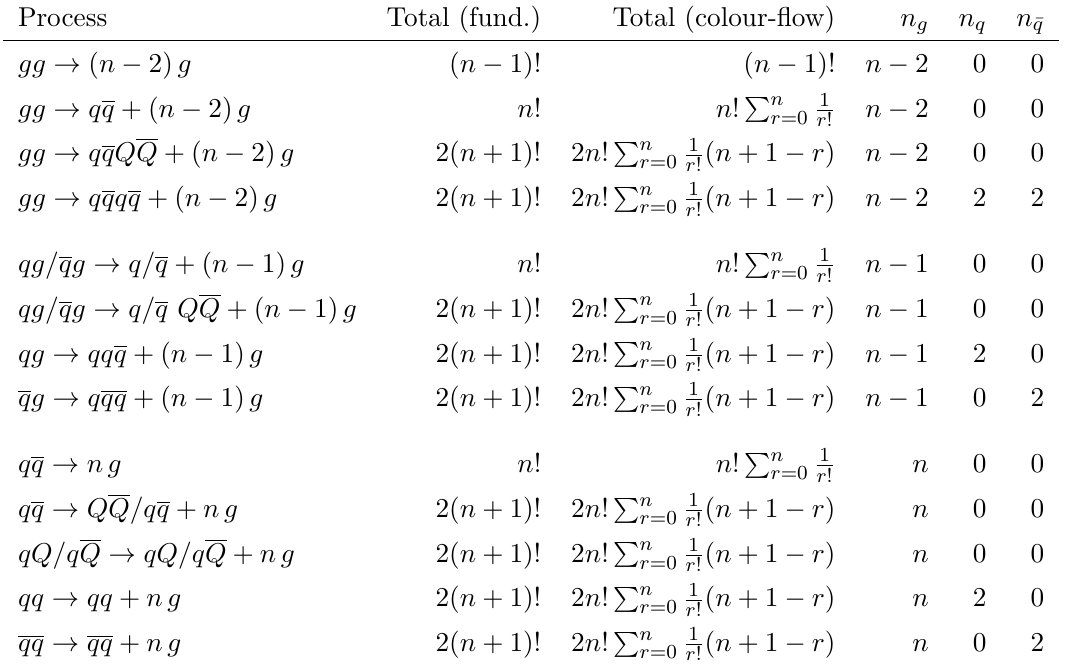
Table 1 . The total number of rows in the colour matrix in the fundamental (second column) and colour-flow (third column) decomposition for various multi-parton processes at hadron colliders. The number of identical final state gluons ( n given in the last three